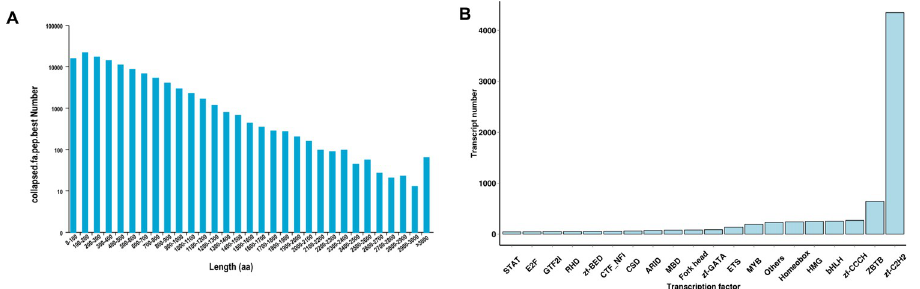
Fig 4. (A) Length distribution of CDSs and (B) type distribution of